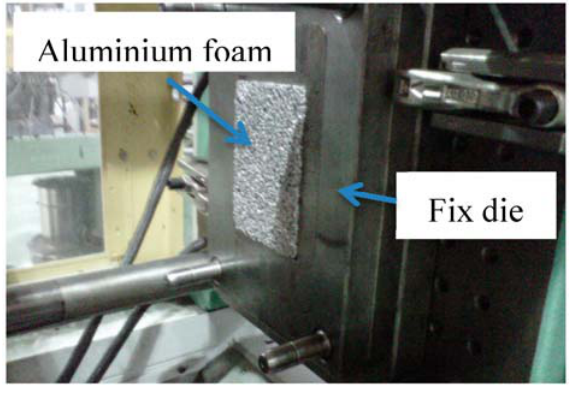
Figure 5. The plastic injection mould with an aluminium foam.